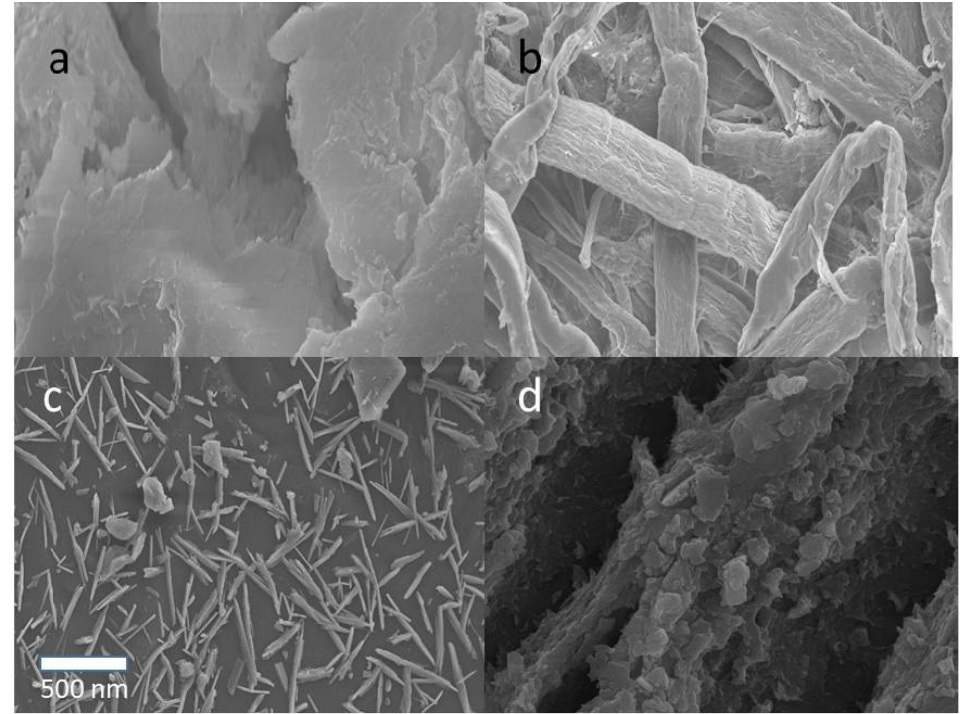
Figure 2. SEM images of ( a ) durian rind, ( b ) durian rind cellulose, ( c ) CNC, and ( d ) CNC-rarasapo- nin.